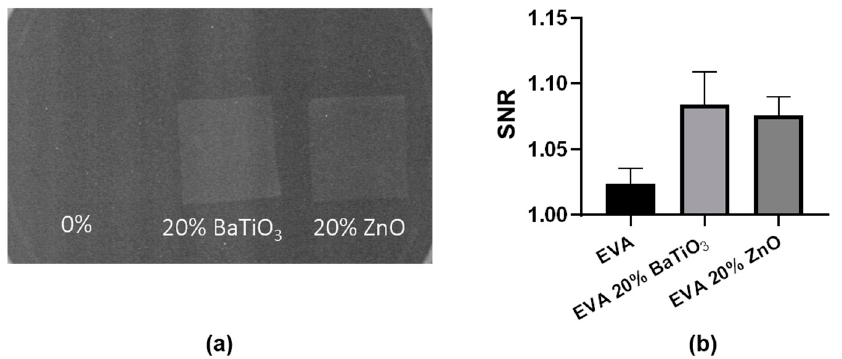
Figure 8. ( a ) Digital image of an X-ray analysis of the EVA-based thin films, and ( b ) analysis of their radiopacity.